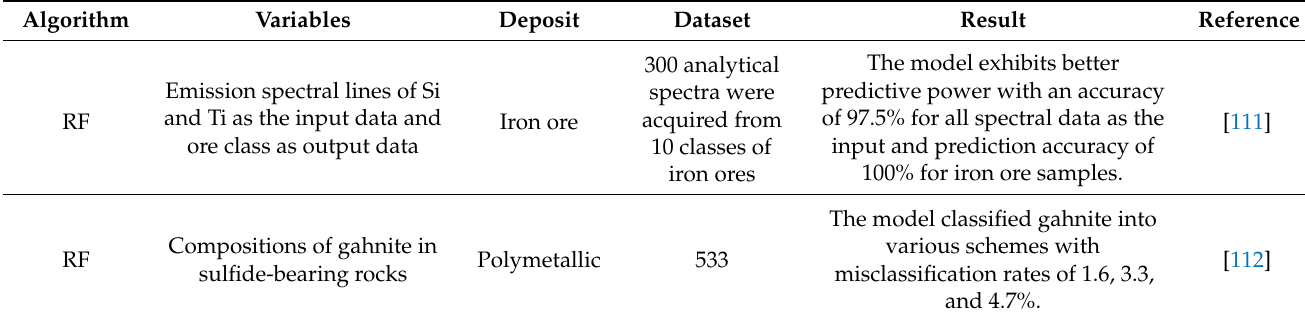
Table 5. Sample case studies of RF-based mineral resource